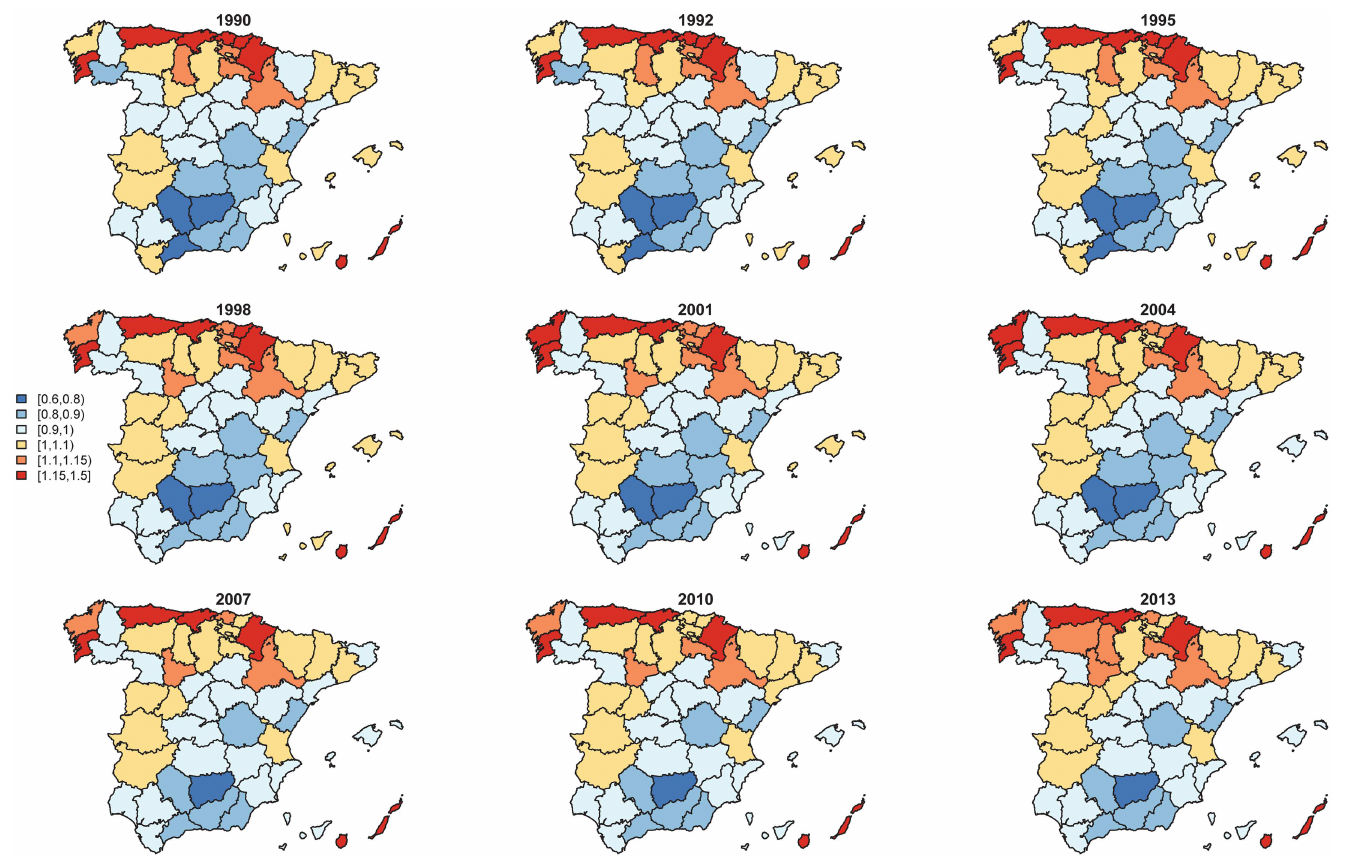
Fig 4. Spatial and spatio-temporal effects together, i.e., e ^ ϕ a þ ^ δ at